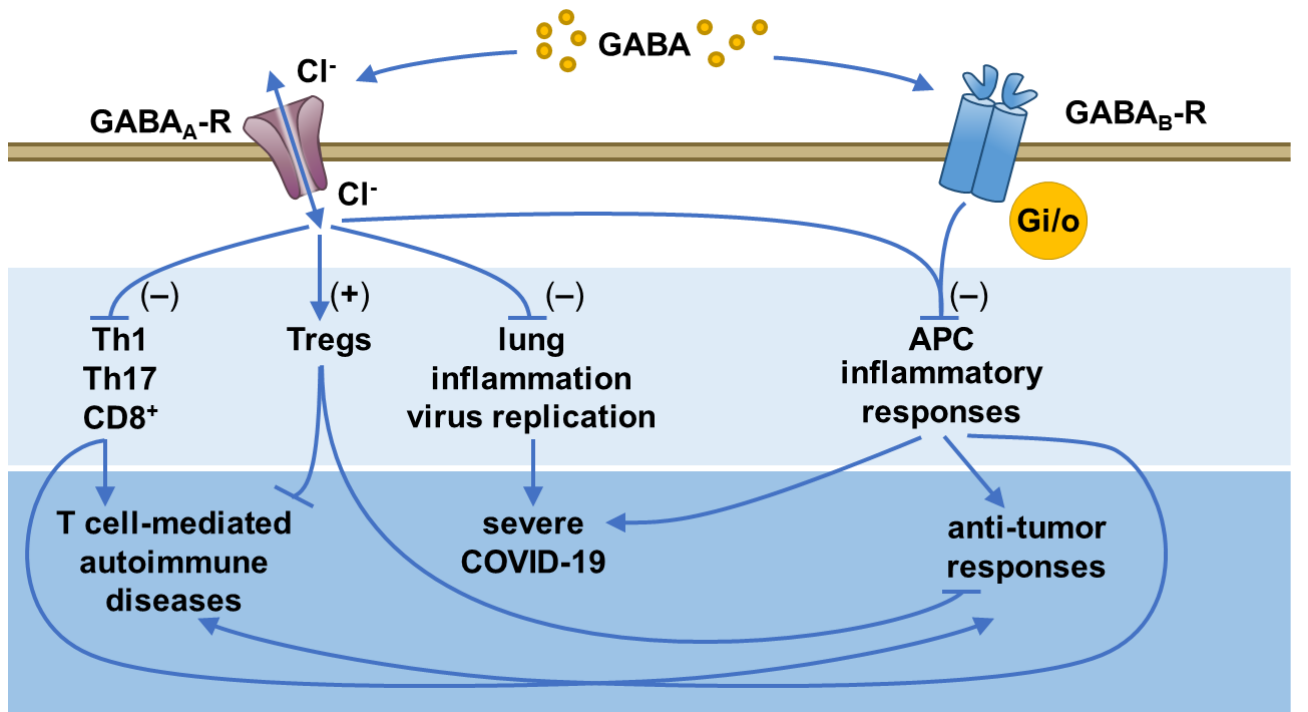
Figure 1. The effects of the GABA and GABA-R system on inflammatory responses in different disease states. GABA A -R agonists (1) inhibit pathogenic/effector Th1, Th17, and CD8 + T cell responses, reducing the production of IFN γ , IL-17, and other pro-inflammatory mediators, (2) limit APC inflammatory activities and shift them toward anti-inflammatory phenotypes, and (3) promote CD4 + and CD8 + Treg responses to enhance the production of anti-inflammatory IL-10 and other mediators. Moreover, GABA B -R agonists inhibit murine APC activation and proinflammatory T1D, MS, rheumatoid arthritis, and Sjogren’s syndrome, as well as inflammation in type 2